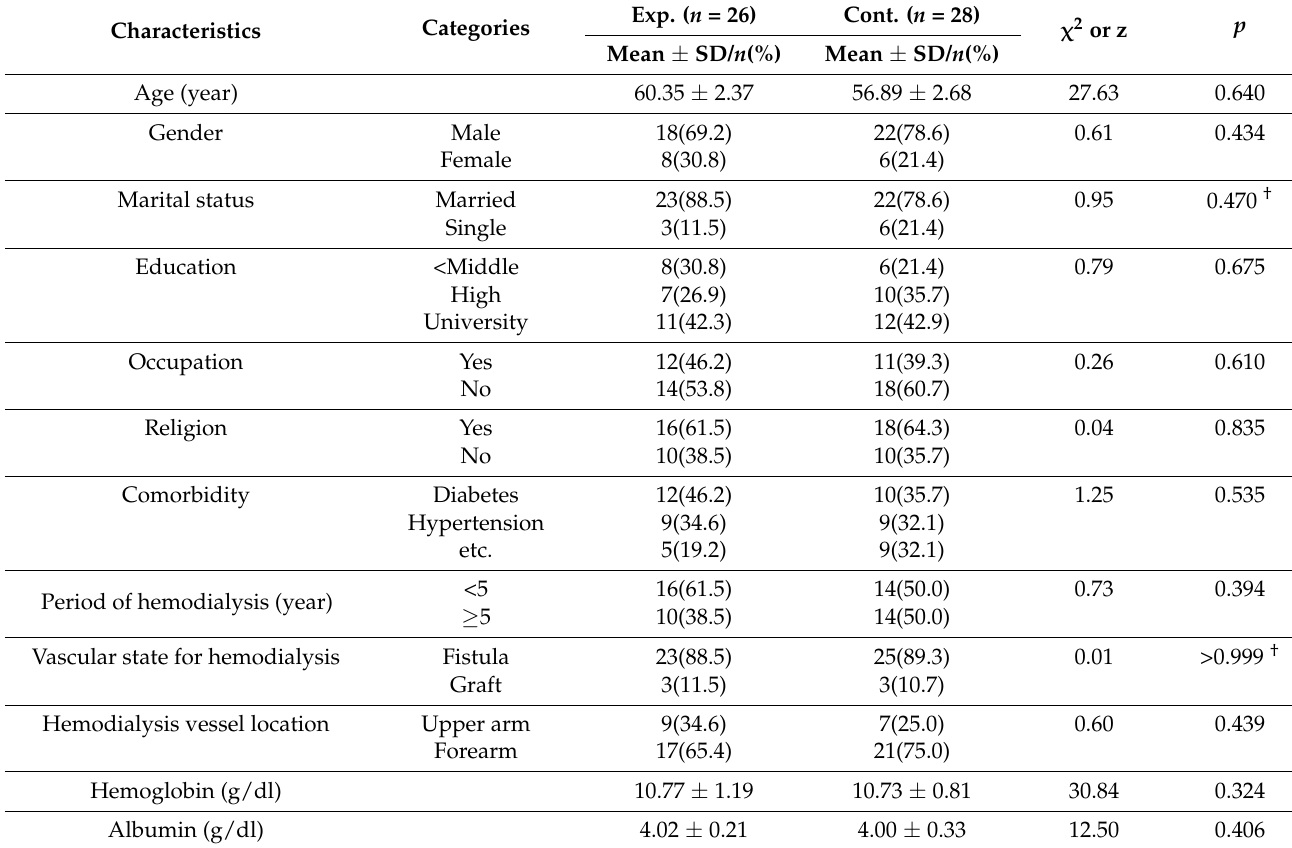
Table 3. Demographic and clinical characteristics of the groups ( n =